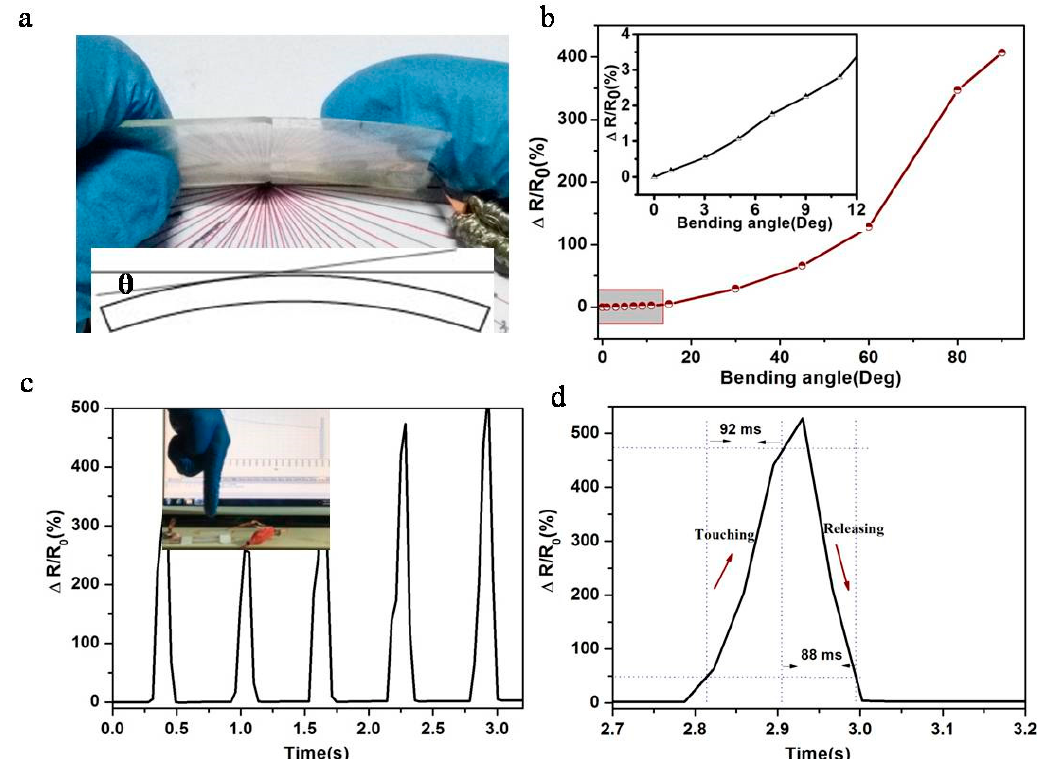
Figure 3. ( a ) Photograph of the bending sensor, Inset: the definition of bending angle θ in a schematic structure. ( b ) The relative resistance change under different bending angles at input voltage of 4 V. ( c ) The relative resistance with the finger touching. Inset: the photograph of finger touching at input voltage of 4 V. ( d ) The relative resistance change in one touching cycle at input voltage of 4 V. The touching and releasing time was defined to 90% high value.